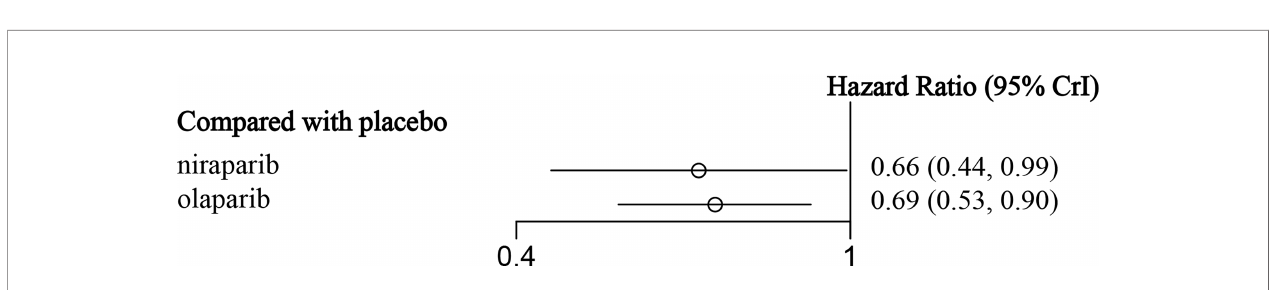
FIGURE 3 | The network plot of the comparisons of all interventions adopted in the network meta-analyses: (A) OS in BRCA-mutated patients; (B) PFS in the overall population; (C) PFS in BRCA-mutated patients; (D) PFS in HRD-positive patients; (E) PFS in HRD-negative patients; (F) AEs of grade 3 to 4 in the maintenance phase. The size of the nodes and the thickness of the connection lines respectively represented the sample size of intervention measures and the number of included analysis tests.